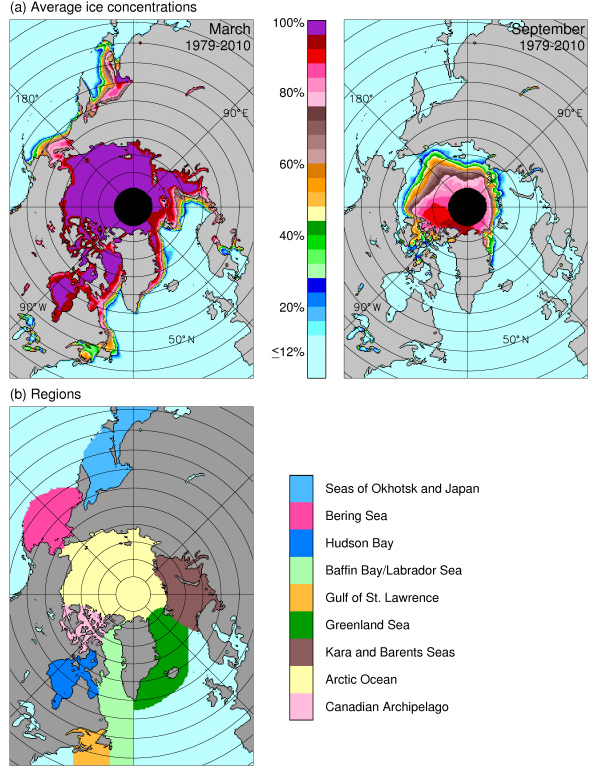
Fig. 1. (a) Maps of Northern Hemisphere March and September sea ice concentrations, averaged over the years 1979–2010, as derived from satellite passive-microwave observations. (b) Location map of the regions used in the analysis (updated Fig. 1 from Parkinson and Cavalieri,